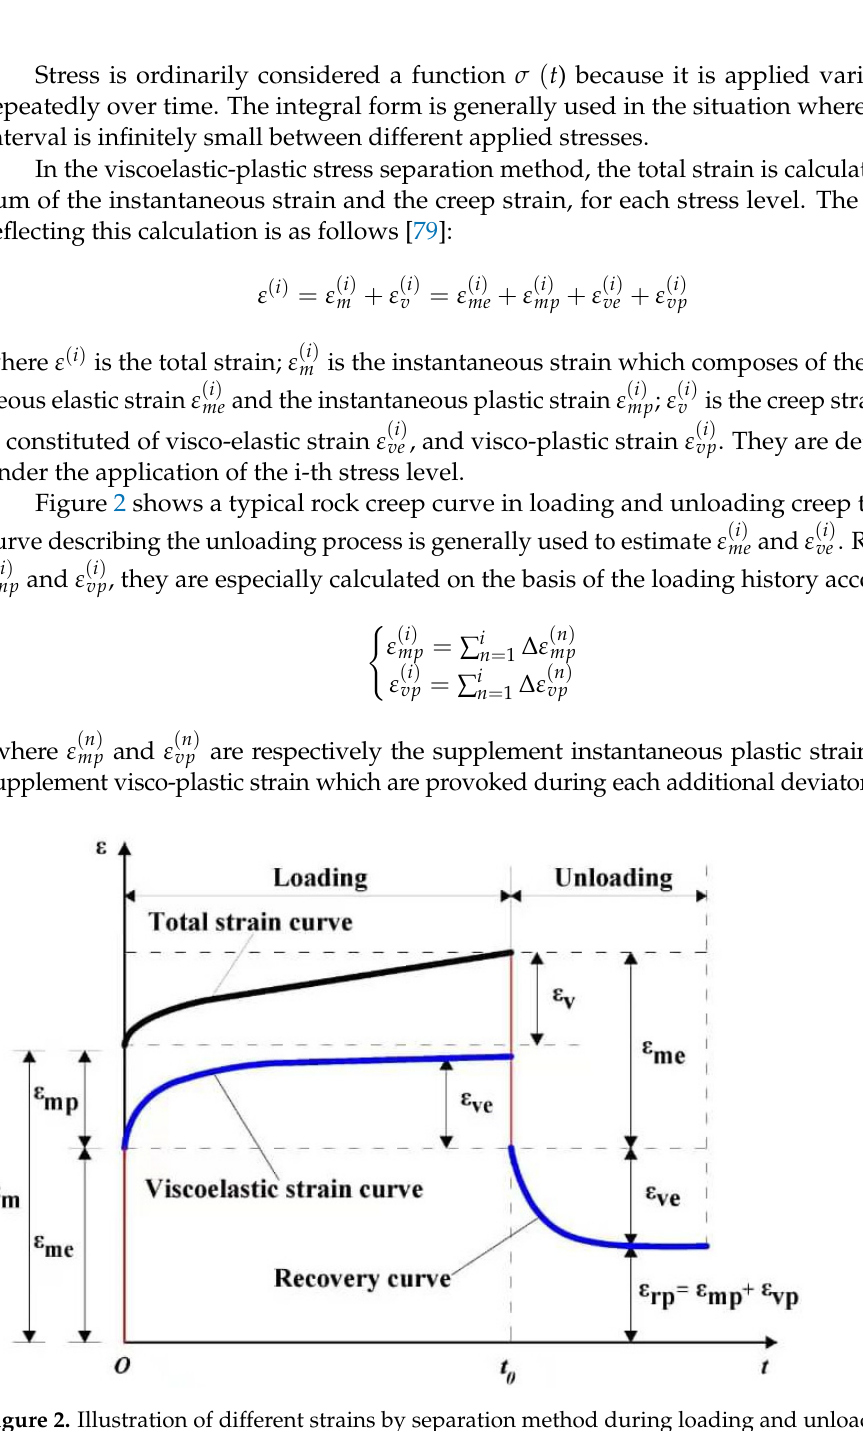
Figure 2. Illustration of different strains by separation method during loading and unloading creep test (after Zhang and Wang, 2021 [80]).